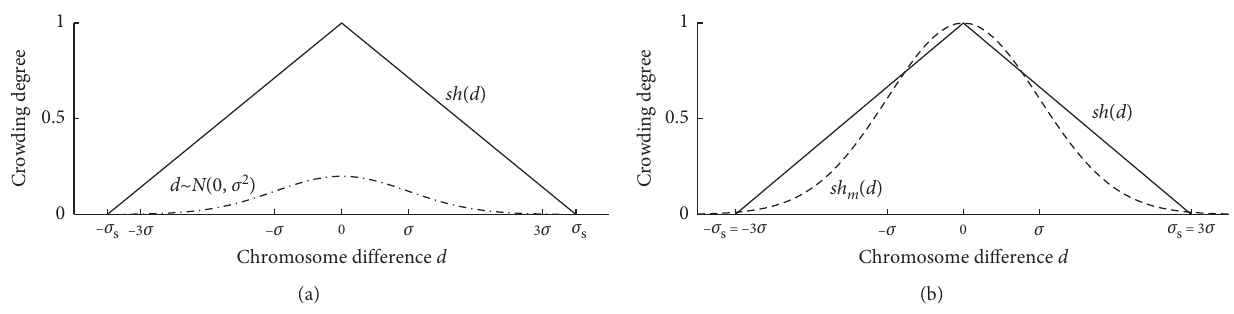
Figure 1: sh ( d ) , sh ( d ) , and Gaussian function. (a) sh ( d ) vs. Gaussian function. (b) sh ( d ) vs. sh m